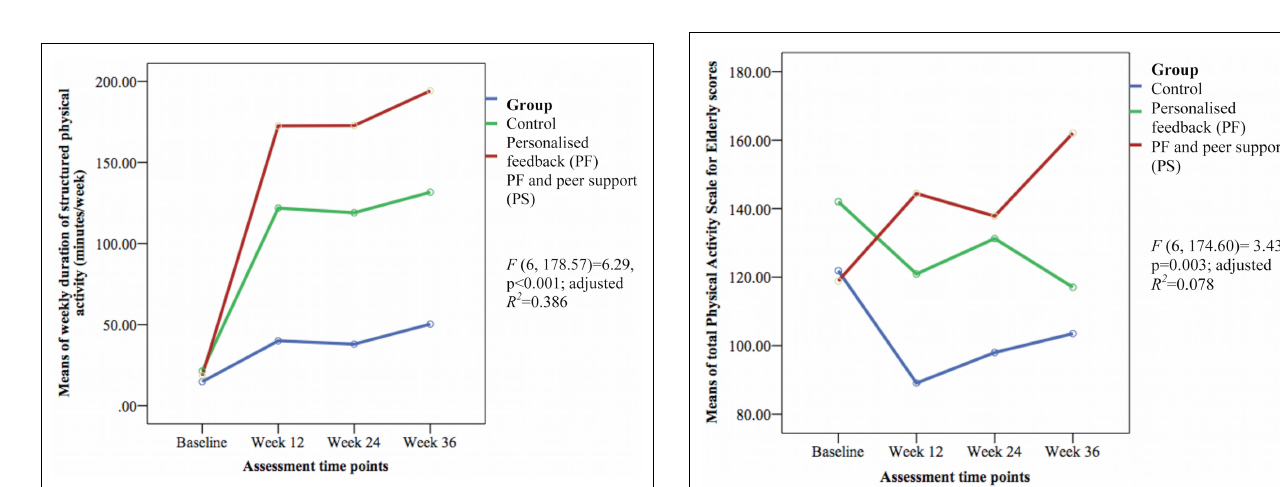
FIGURE 5 | Mean differences on Physical Activity Scale for Elderly (PASE) scores between groups over time